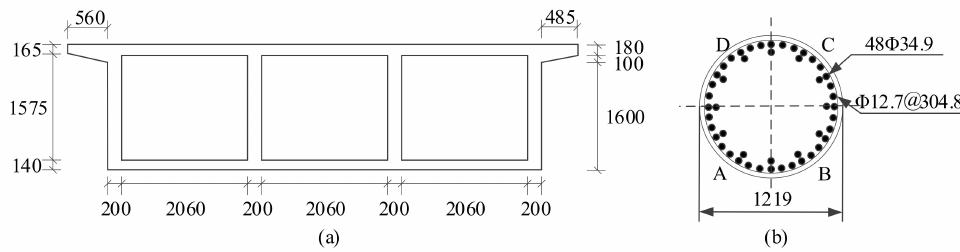
Figure 2. The section of the girder and the pier. ( a ) The section of the girder; ( b ) the section of the pier.